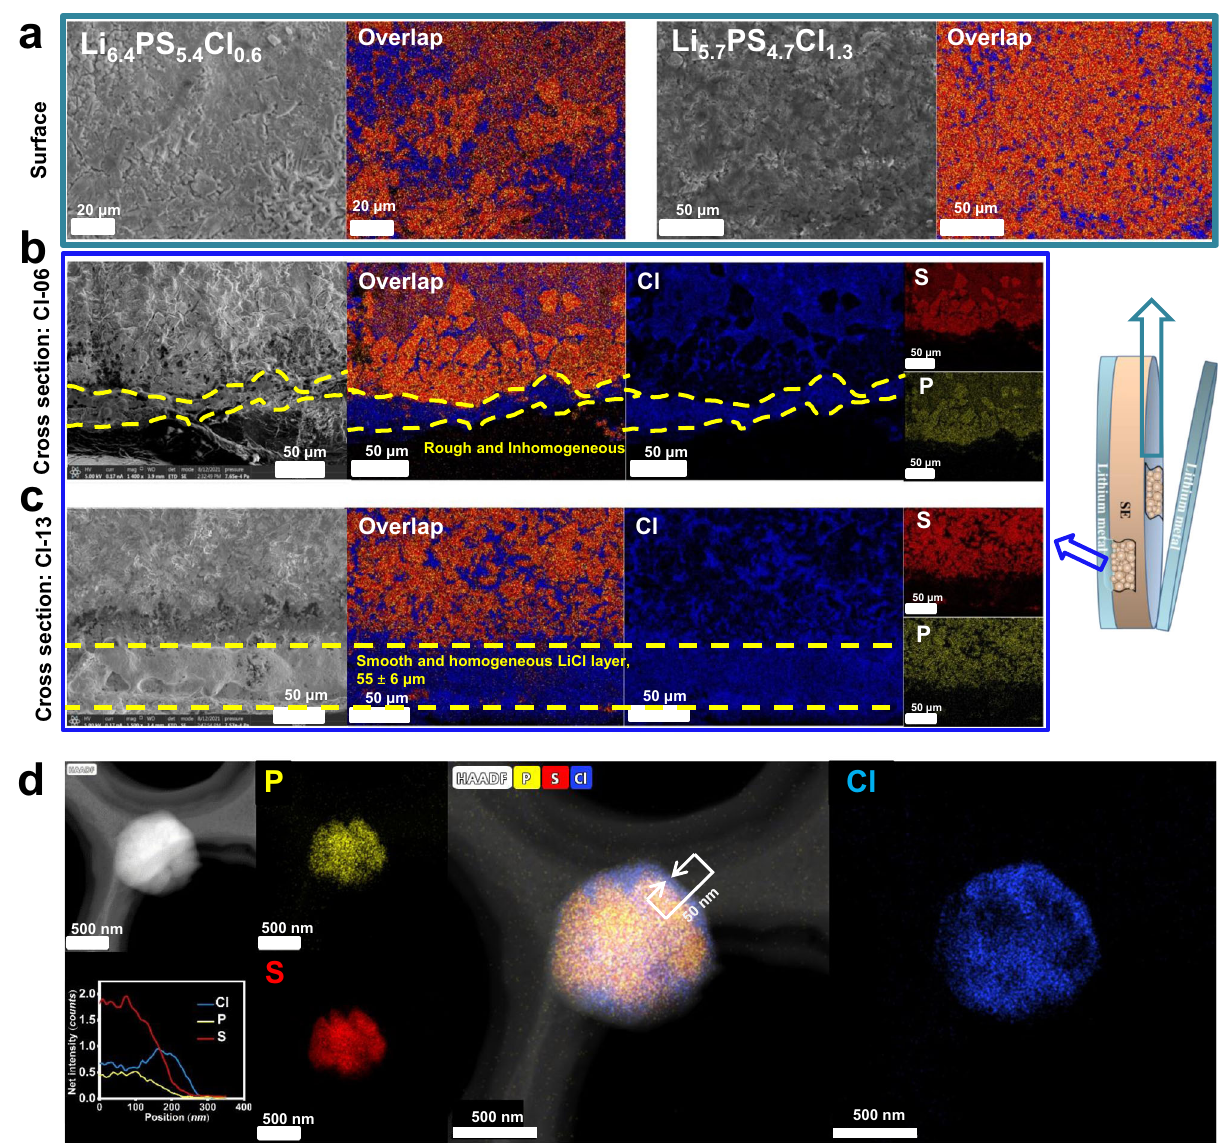
Fig. 9 In fl uence of chlorinity on microstructure. a – c SEM and EDS analyses on the Li|SE interface for Li||Li symmetric cells after plating/stripping cycling using Cl-06 (200 cycles) and Cl-13 (400 cycles) SEs. a SEM and EDS images on fracture surface. Cross-sectional SEM and EDS images for Cl-06 ( b )